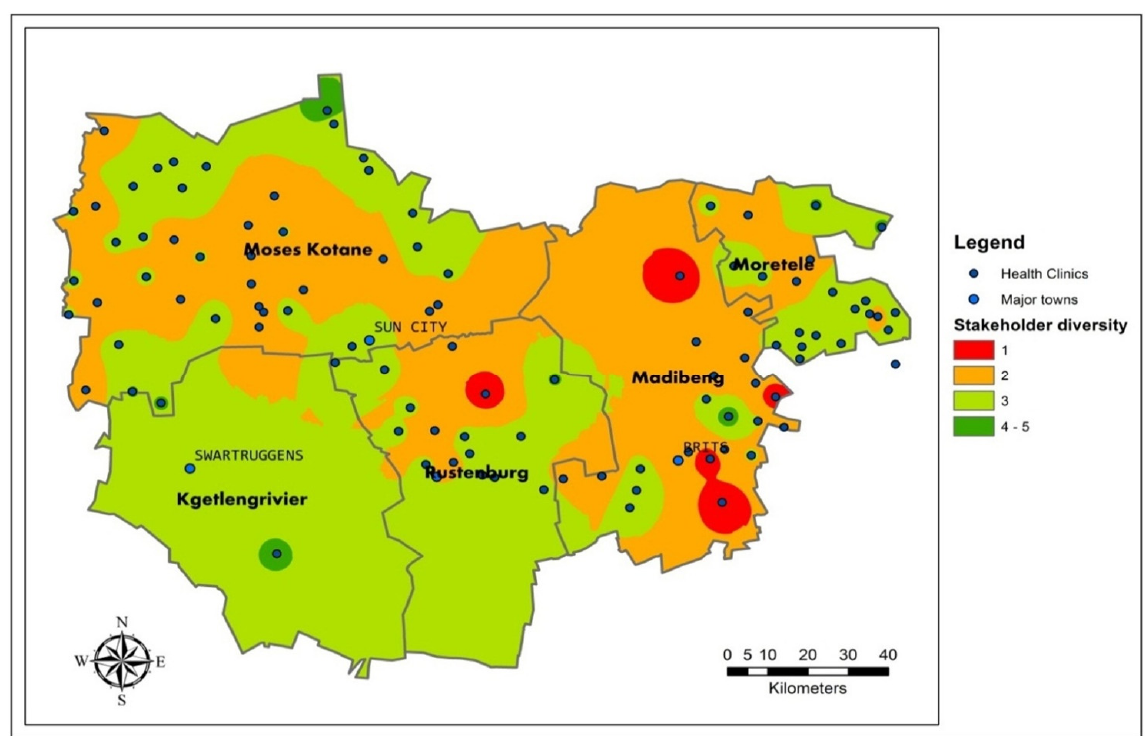
Figure 2. Diversity of stakeholders involved in health clinic gardens across all municipalities in the Bojanala district.